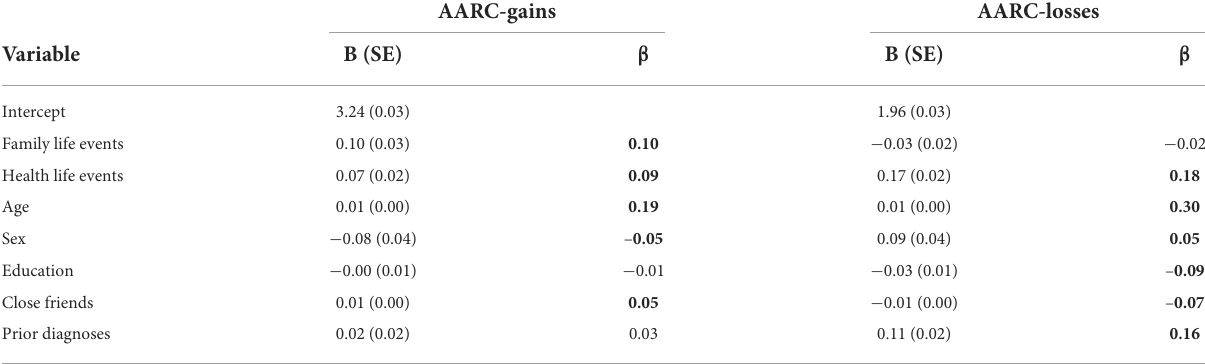
TABLE 4 Investigating the predictive effects of accumulating life events for awareness of age-related